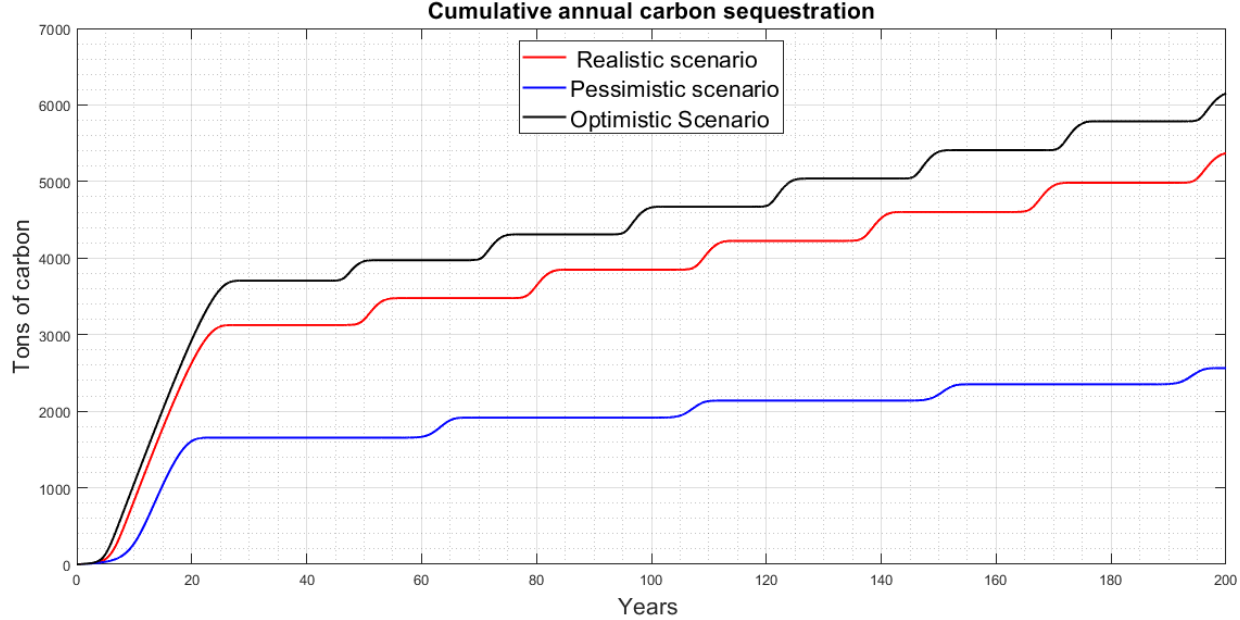
Figure 3. Cumulative carbon in the three scenarios for a period of 200 years.